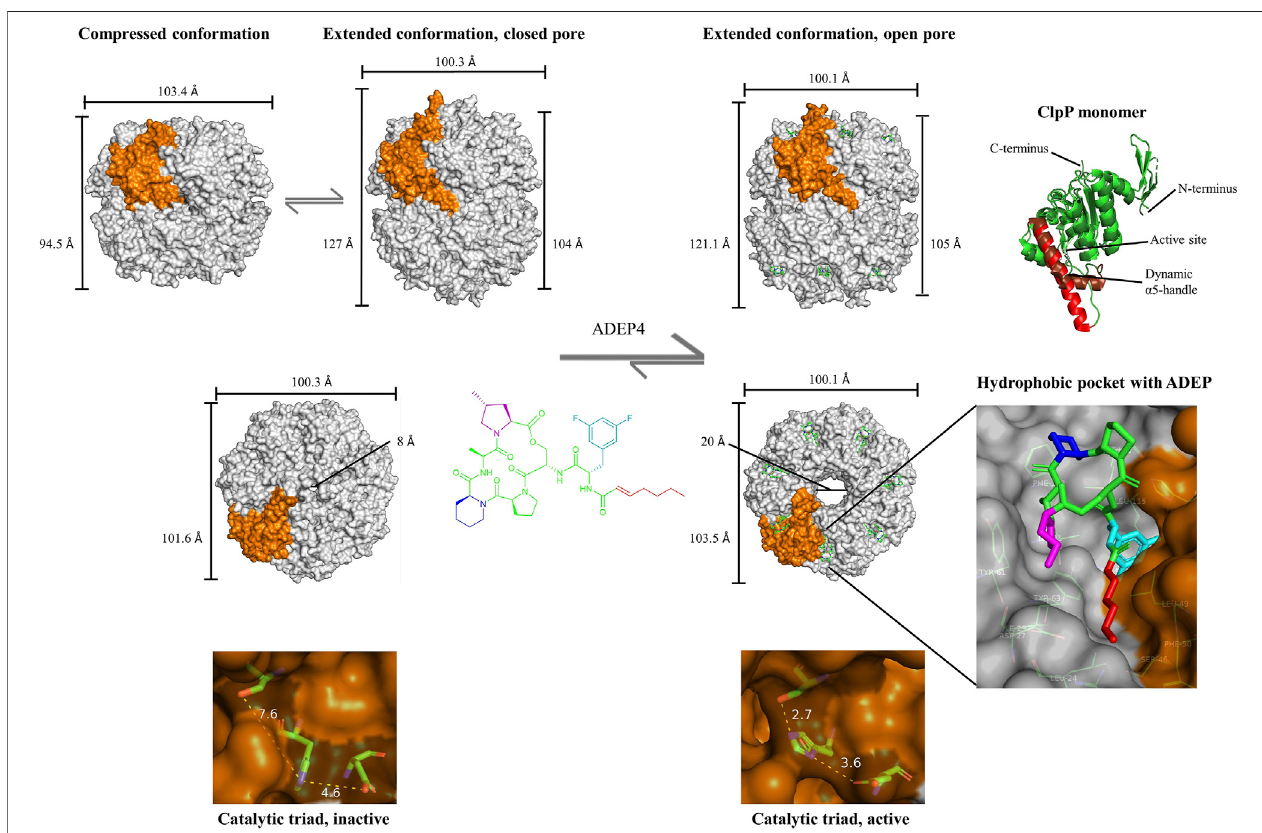
FIGURE 1 | Impact of ADEP on ClpP at the molecular level. Conformational dynamics of ClpP and conformational control exerted by ADEP. Upper row, side view on the tetradecameric barrel of ClpP, switching between the “ compressed ” and “ extended ” state as the two endpoints of the conformational transition. The term “ compact ” is used for an intermediate state (not shown). ADEP stabilizes the extended, active conformation. A single ClpP protomer within the barrel is highlighted in orange.Singleprotomershowingthedynamic α 5helix(right).Middle,topviewontheapicalsurfaceofClpP,depictingtheclosedporein apo ClpPandthewidened poreuponADEP4binding.Magni fi edH-pocketformedbytwoneighboringprotomersandoccupancybyADEP4.Bottom,magni fi edcatalytictriadsofthecompressed, inactive vs. extended, active conformation. In the nucleophilic attack of the catalytic serine on the peptide bond carbonyl, the serine hydroxylproton isabstracted by the histidine imidazole, and the positive charge at the histidine is stabilized by the carboxy group of the aspartate. The hydrogen network between the catalytic triad is essentialfortheinteractionandtheoptimaldistanceforahydrogenbondrangesfrom2.7to3.3 Å. S.aureus ClpPstructuresareshown:Compressedbarrel(PDBcode: 4EMM) (Ye et al., 2013); compressed monomer (PDB code: 3QWD) (Geiger et al., 2011), extended barrel with closed (PDB code: 6TTY) and open pore (PDB code: 6TTZ) (Malik et al.,